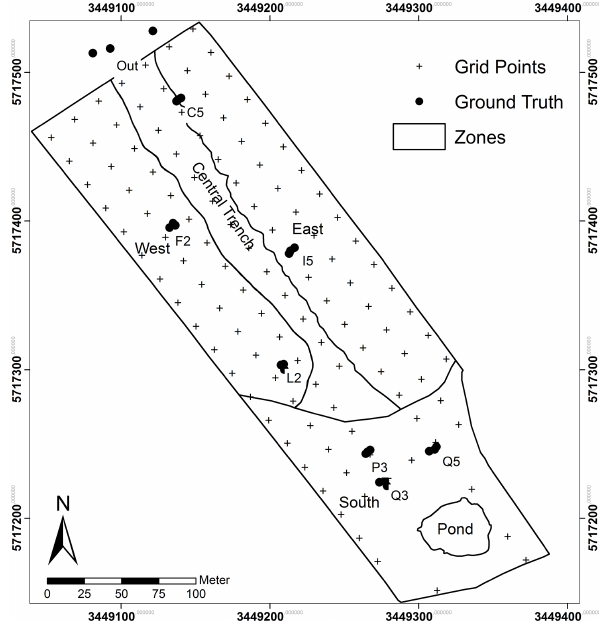
Figure 1. Schematic map of the artificial catchment “Chicken Creek” showing grid points, ground truth sites and zones, delineat- ing areas with slightly different soil